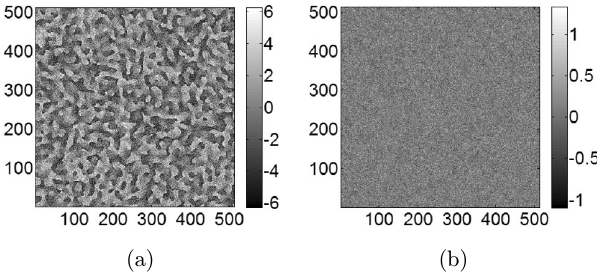
Fig. 7. The phase pro¯le (a) displayed at P2 plane, and the amplitude error (b) at the same plane. The amplitude error was calculated by subtracting Fig. 6(c) from Fig. 5(b). The units of the gray bars are radians in (a), and the un-normalized gray- scale in (b), respectively.